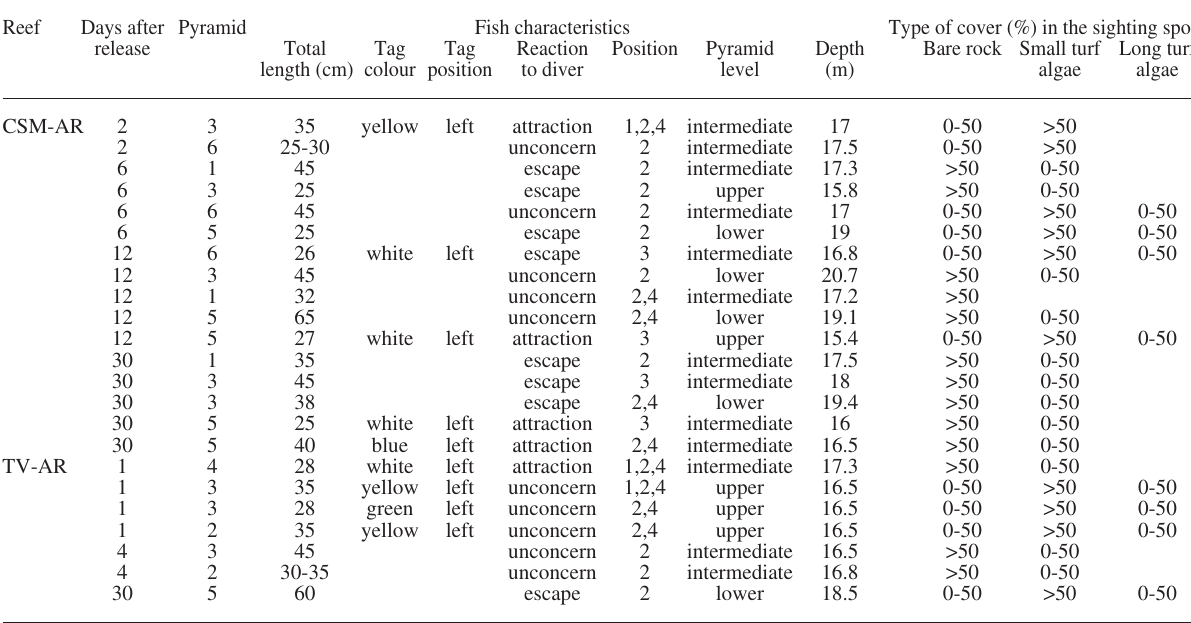
Table 5. – Sightings of dusky groupers during the post-release monitoring surveys carried out in the artificial reefs of Capo S. Marco (CSM- AR) and Torre Verdura (TV-AR). Position: 1, on the pyramid of release; 2, among blocks of the pyramids; 3, around pyramids; 4, inside the holes of the blocks.